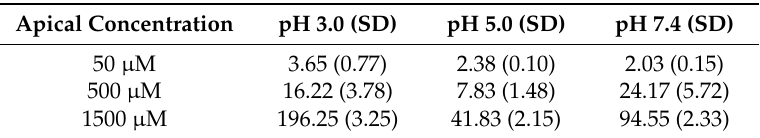
Table 2. Anthocyanin concentrations (µM) collected from basolateral chambers with varying apical pH values after 3 h treatment at 37 °C.